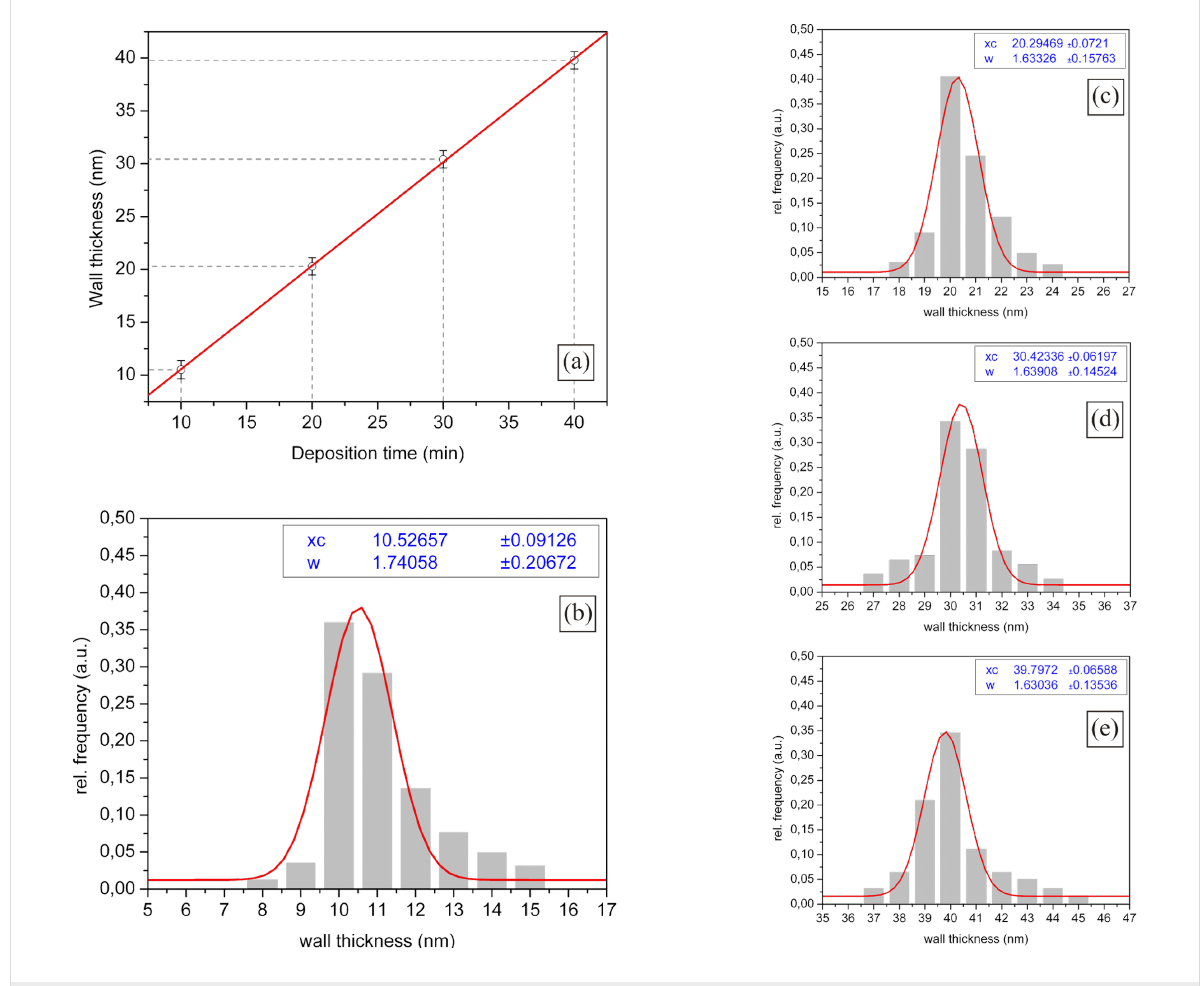
Figure 2: (a) Deposition time vs. wall thickness plot. (b) Gaussian distribution of 10 nm wall thickness ITO-NTs. (c–e) Gaussian distribution of 20, 30 and 40 nm wall thickness ITO-NTs.